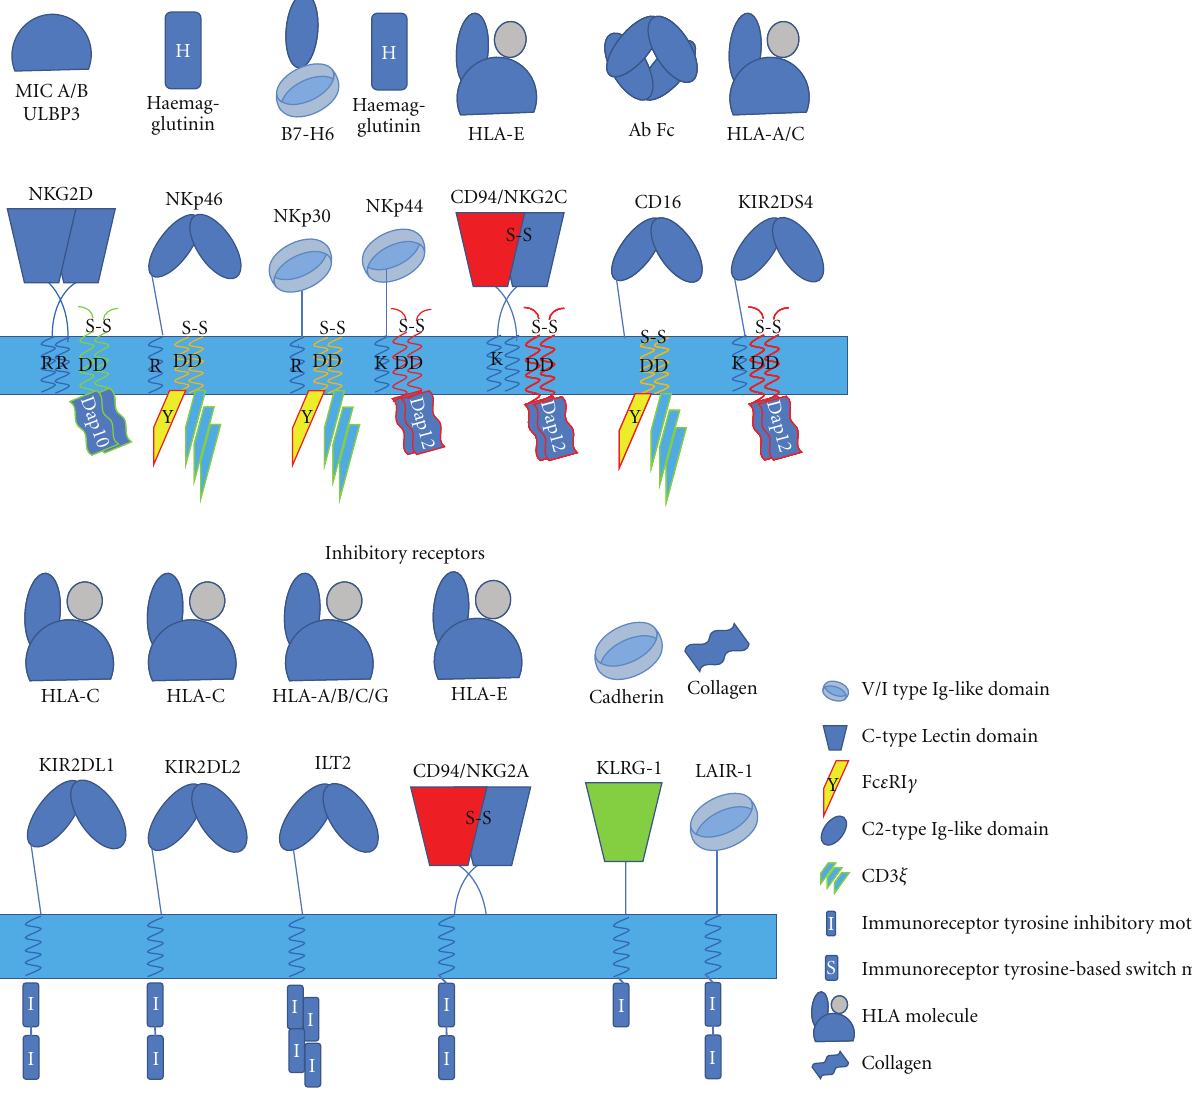
Figure 1: Overview of the structurally characterized activating and inhibitory human NK receptors and their ligands. The upper panel displays the chief activating receptors found on human NK cells including the homodimer NKG2D, the natural cytotoxicity receptors, NKp46, NKp44, and NKp30, the c-type lectin heterodimer CD94: NKG2C, the Fc receptor CD16, and also the KIR activating receptors. The associated cytoplasmic signaling molecules for these activating receptors which include DAP12, DAP10, and CD3 ζ /Fc ε RI γ and the specific transmembrane residues which facilitate the interaction are also shown. The lower panel illustrates the structurally characterized inhibitory receptors found on NK cells. These include the KIR receptors KIR 2DL1 and KIR 2DL2 which have been characterized in complex with peptide bound MHC class I molecules, the heterodimeric CD94:NKG2A which binds to peptide bound HLA-E. The C-type lectin receptor KLRG-1 which binds to cadherin and the NK cell receptor LAIR-1 molecule which binds to collagen are also shown. The known ligands for both the activating and inhibitory receptors are illustrated above their respective NK cell